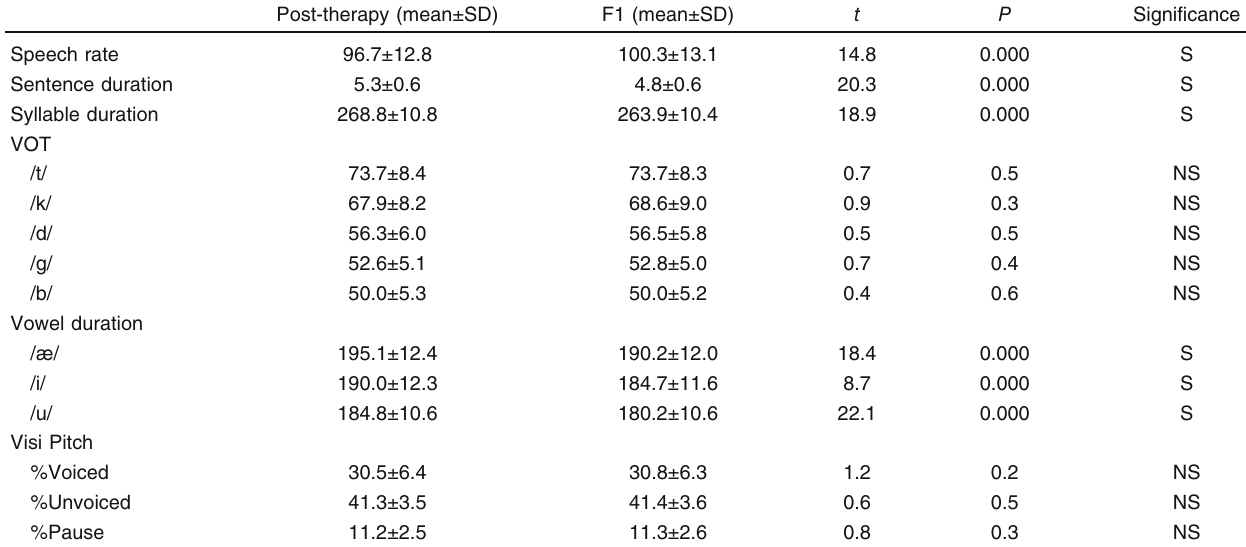
Table 11 Correlation between post-therapy and first follow-up in the study group as regards speech rate, sentence duration, syllable duration, voice onset time, vowel duration, and Visi Pitch